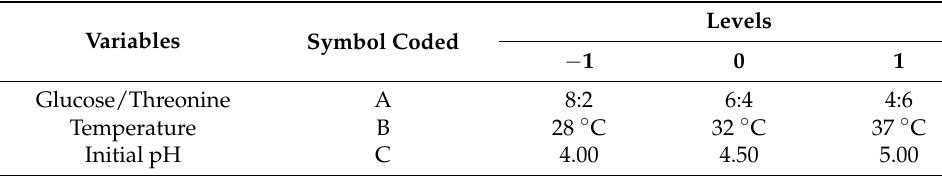
Table 1. The factor and level of Box–Behnken experiment for n-propanol.